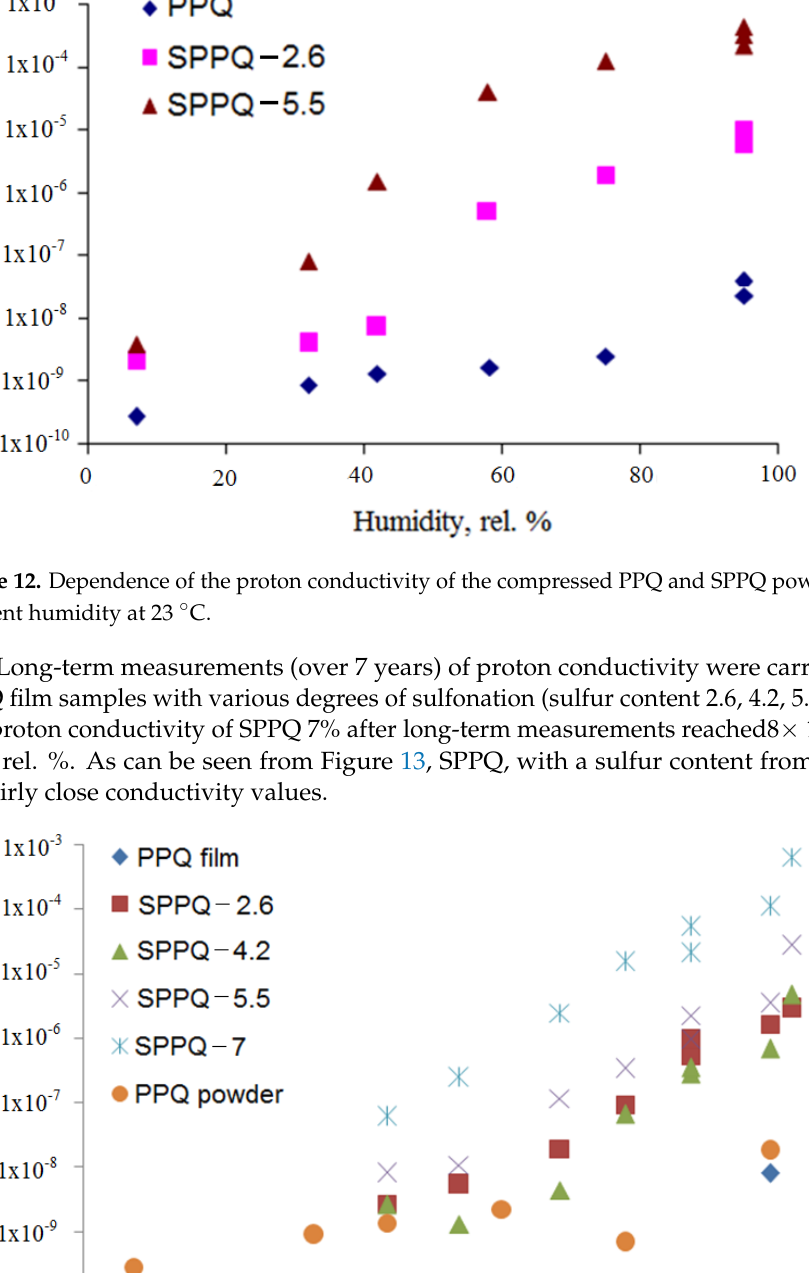
14 of 18 Figure 11. Double units of PPQ with one and two sulfogroups around the oxygen bridge. 3.7. Impedance Spectroscopy The conductivity of the initial PPQ in the form of a powder and a film does not exceed 10 − 8 S/cm, even at a humidity of 95 rel. %. The investigation of the influence of ambient